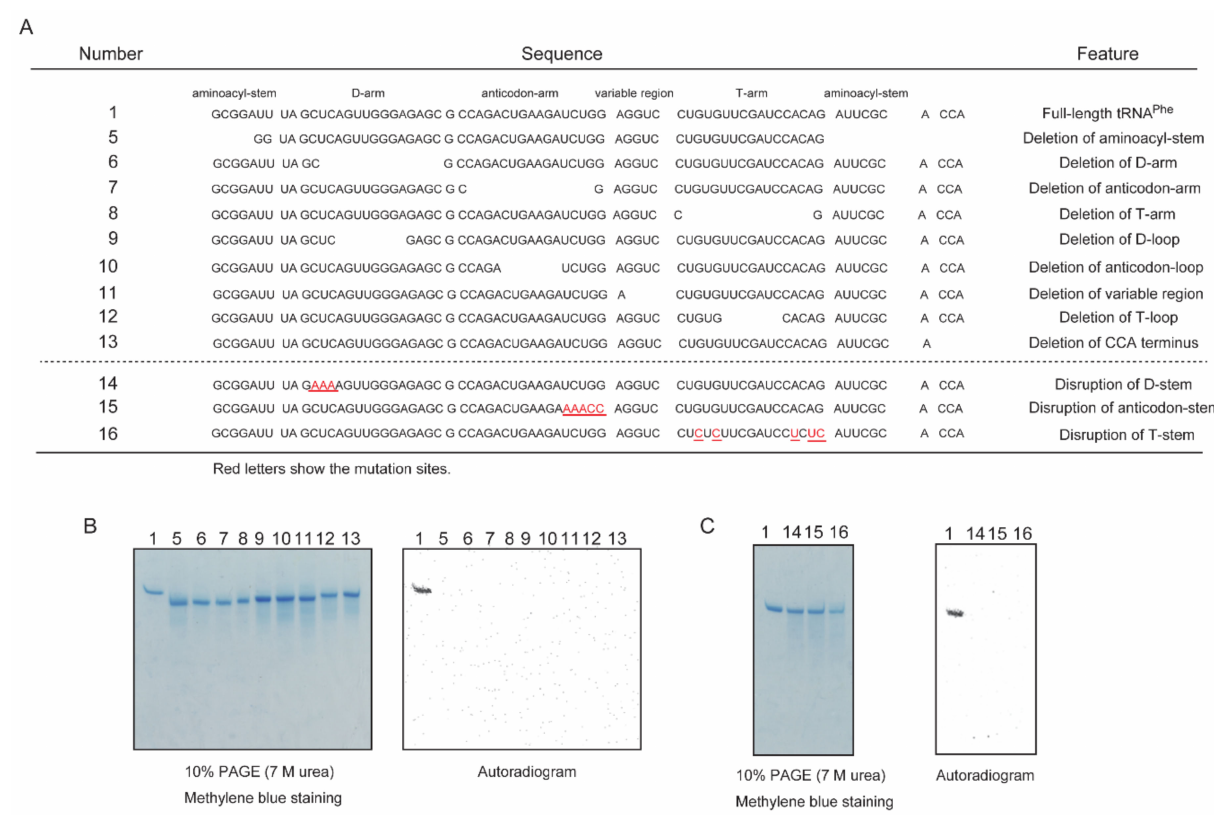
Figure 4. None of the deletion and stem-disruptant mutant tRNA Phe transcripts are methylated by the Trm11-Trm112 complex. ( A ) Sequences of tRNA Phe deletion mutants (Numbers 1–13) and stem- disruptant mutant (Numbers 14–16) are shown. ( B ) The deletion mutant tRNA Phe transcripts were incubated with Trm11-Trm112 and 14 C-AdoMet and then loaded onto a 10% polyacrylamide gel con- taining 7 M urea. After the electrophoresis, the gel was stained with methylene blue and dried ( left ). An autoradiogram of the gel was obtained ( right ). One full-length tRNA Phe transcript was methy- lated by Trm11-Trm112. ( C ) Methylation of the stem-disruptant mutant tRNA Phe transcripts was analyzed using the same method described in panel ( B ). Disruption of D-stem, anticodon-stem or T-stem abolishes methylation by